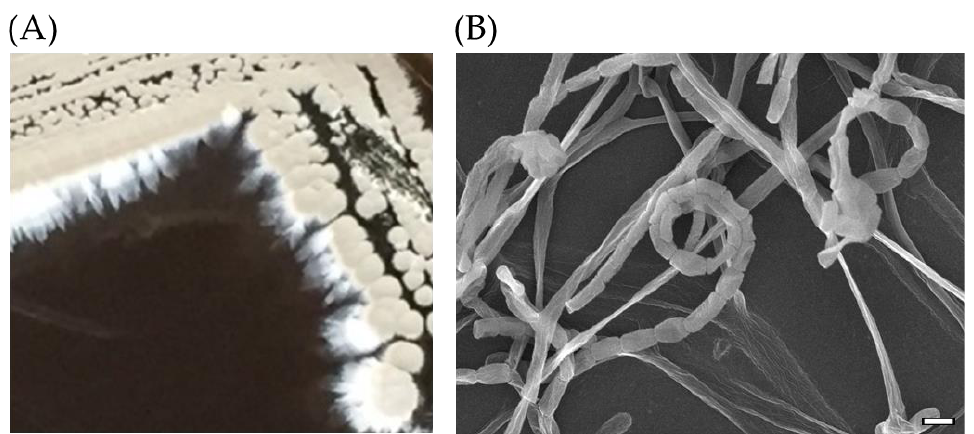
Figure 1. Morphology of SC26. ( A ) Colony morphology of SC26 on YM1 agar after incubation at 30 ◦ C for 6 days. ( B ) Spore chains of SC26 under field-emission scanning electron microscope (FE-SEM). The bar indicates 1 µ